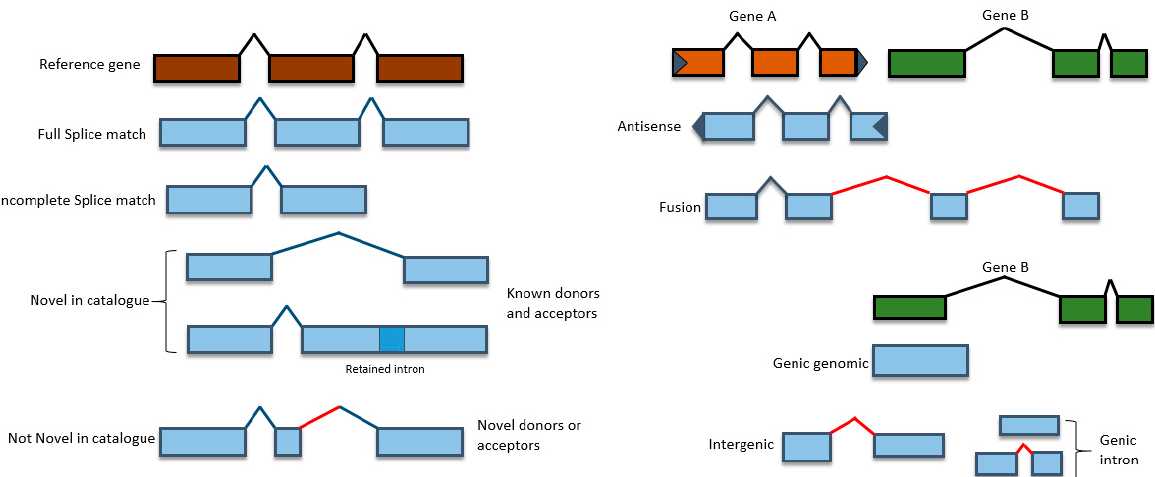
Figure 1. Alternative spliced isoforms based on the SQANTI classification according to their splice junctions and donor and acceptor sites. Splice donors and acceptors are indicated in blue lines and red lines indicate novel donors and acceptors. The categories are full splice match (FSM), incomplete splice match (ISM), novel in catalogues (NIC), not novel in catalogues (NNC), antisense, fusion, genic genomic, intergenic, and genic intron. Black boxes refer to reference gene linked with black lines as introns and grey boxes refer to transcripts in which blue and red lines represent introns where blue introns are formed due to known splice sites and red introns are formed due to unknown splice sites (donor or acceptors).